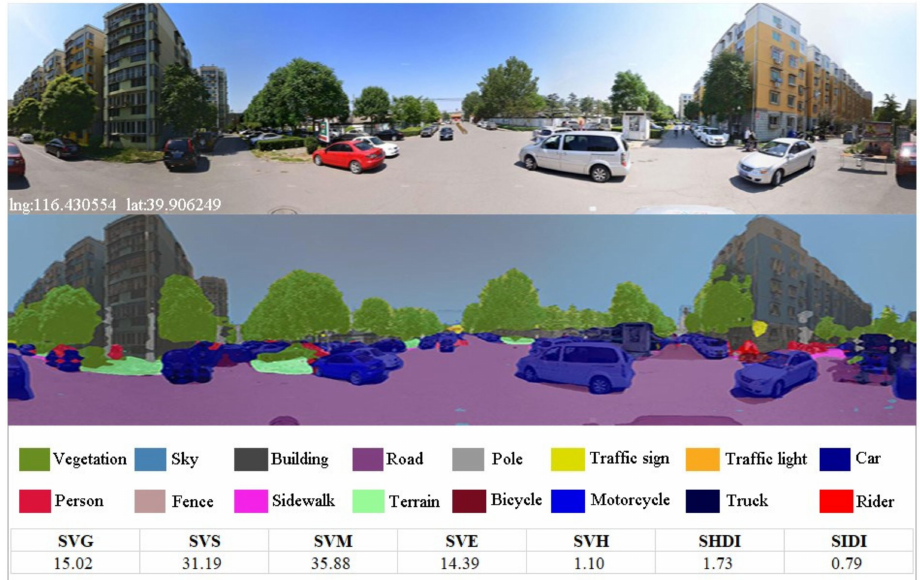
Figure 6. Example of SVI semantic segmentation results and the values of public space visual perception factors calculated based on the SVI. Abbreviations: street visual greening (SVG), street visual sky openness (SVS), street visual enclosure (SVE), street visual motorization (SVM), street visual humanization (SVH), Shannon’s diversity index (SHDI), Simpson’s diversity index